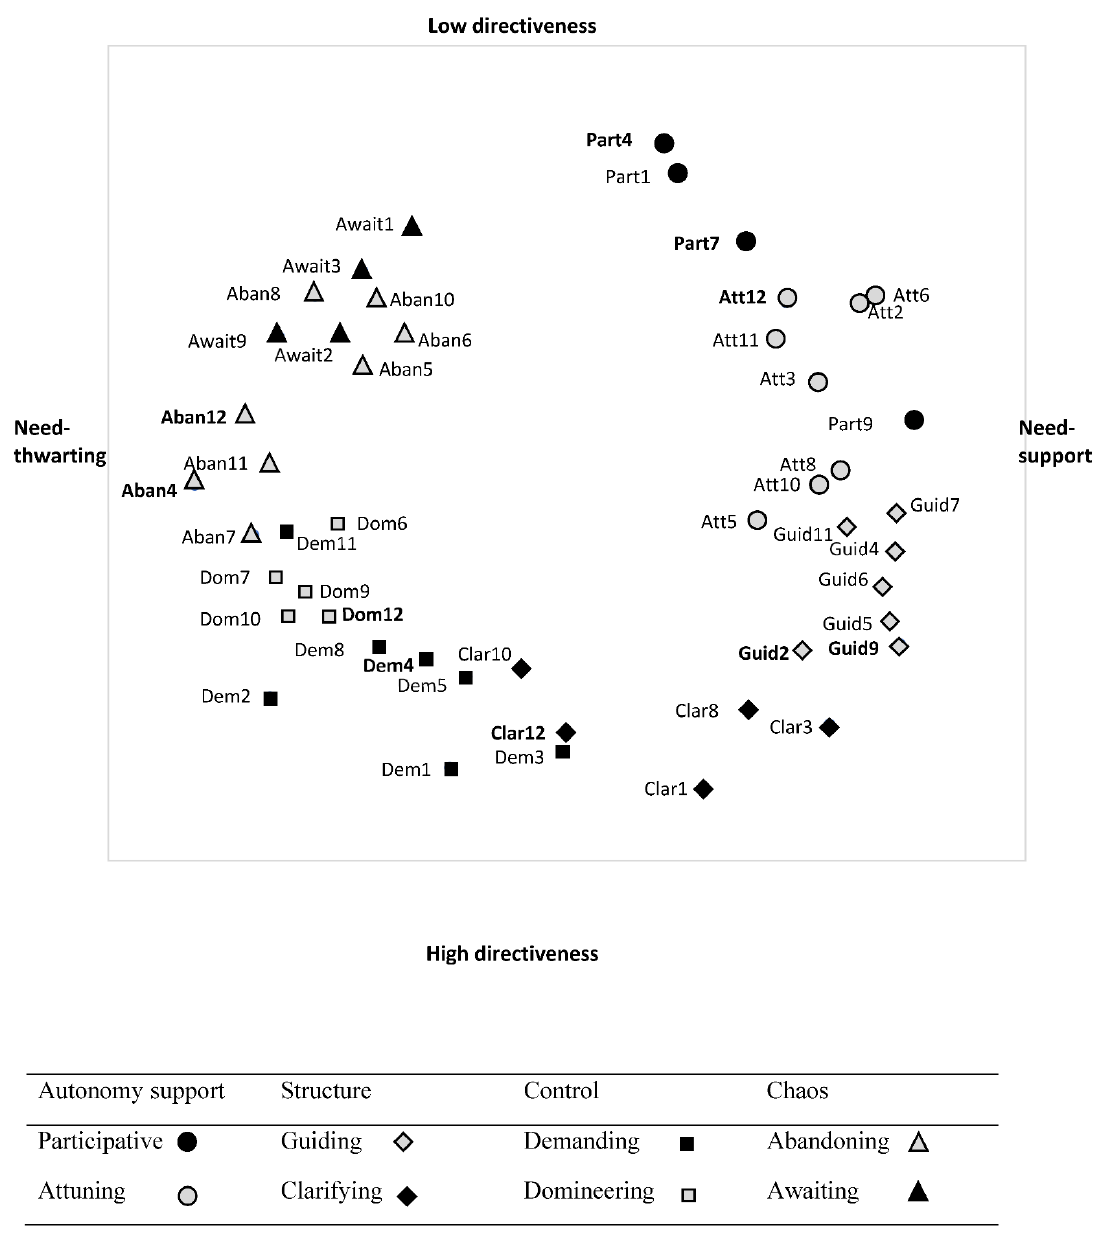
Figure 3. Two-dimensional representation of the SIS-PE items in Belgium.